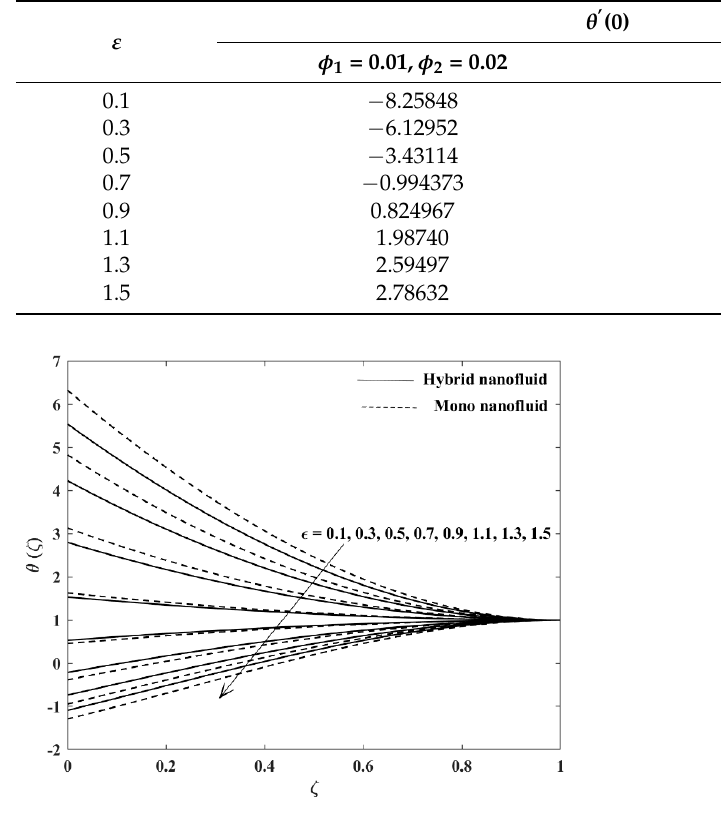
Figure 7. Changes in the unsteadiness parameter or ε under the specified conditions of Figure = = = = − 0.05, 1.2,Pr 7, 1.2 We M S , and = 0.8 m lead to variations in the temperature profiles. x